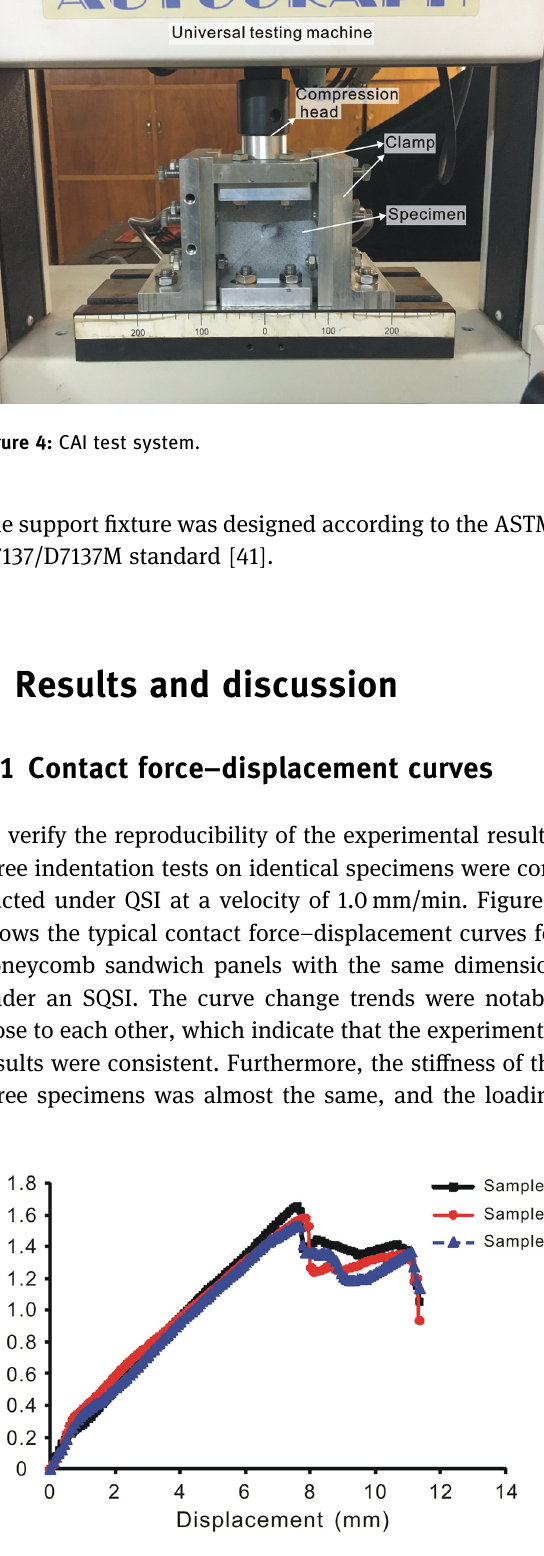
Figure 5: Force – displacement curves of specimens subjected to SQSI.